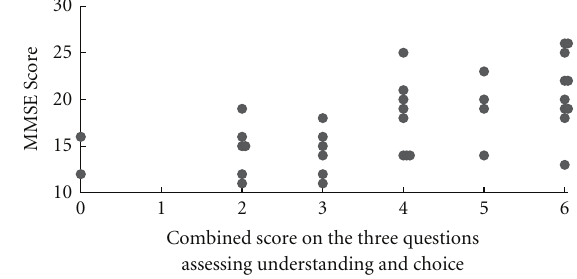
Figure 2: Relation of scores on the Mini-Mental State Exam to scores on questions assessing understanding and choice ( r = 0 . 61, P < 0 .